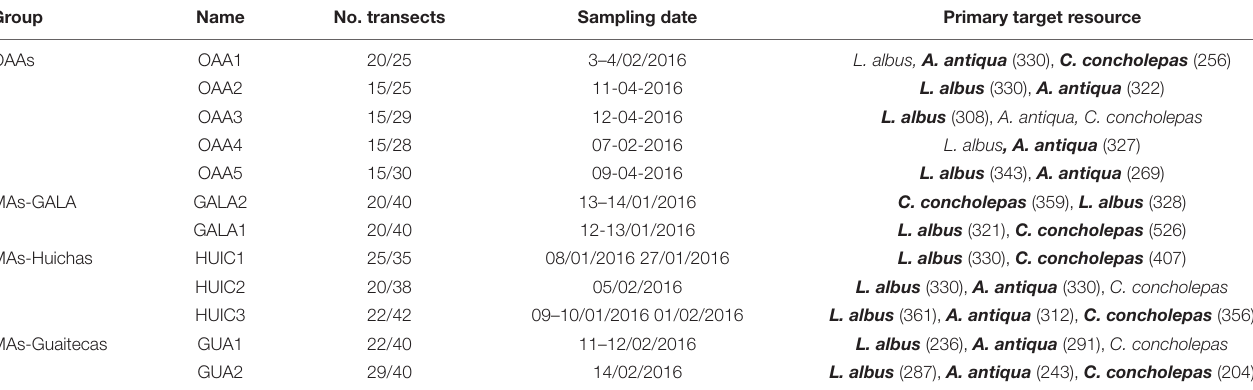
TABLE 2 | Primary target resource evaluated per area, number of transects for benthic community/commercial species and sampling dates.